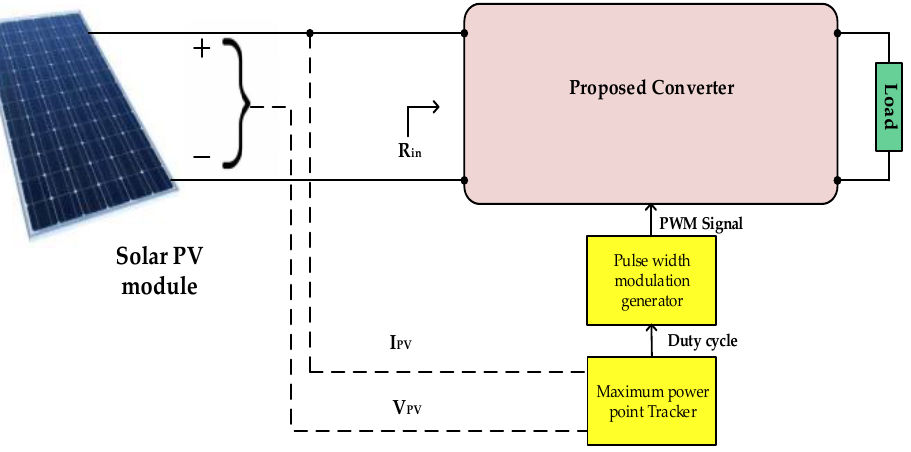
Figure 2. A simplified block schematic of the MPPT circuitry found in a solar PV module.